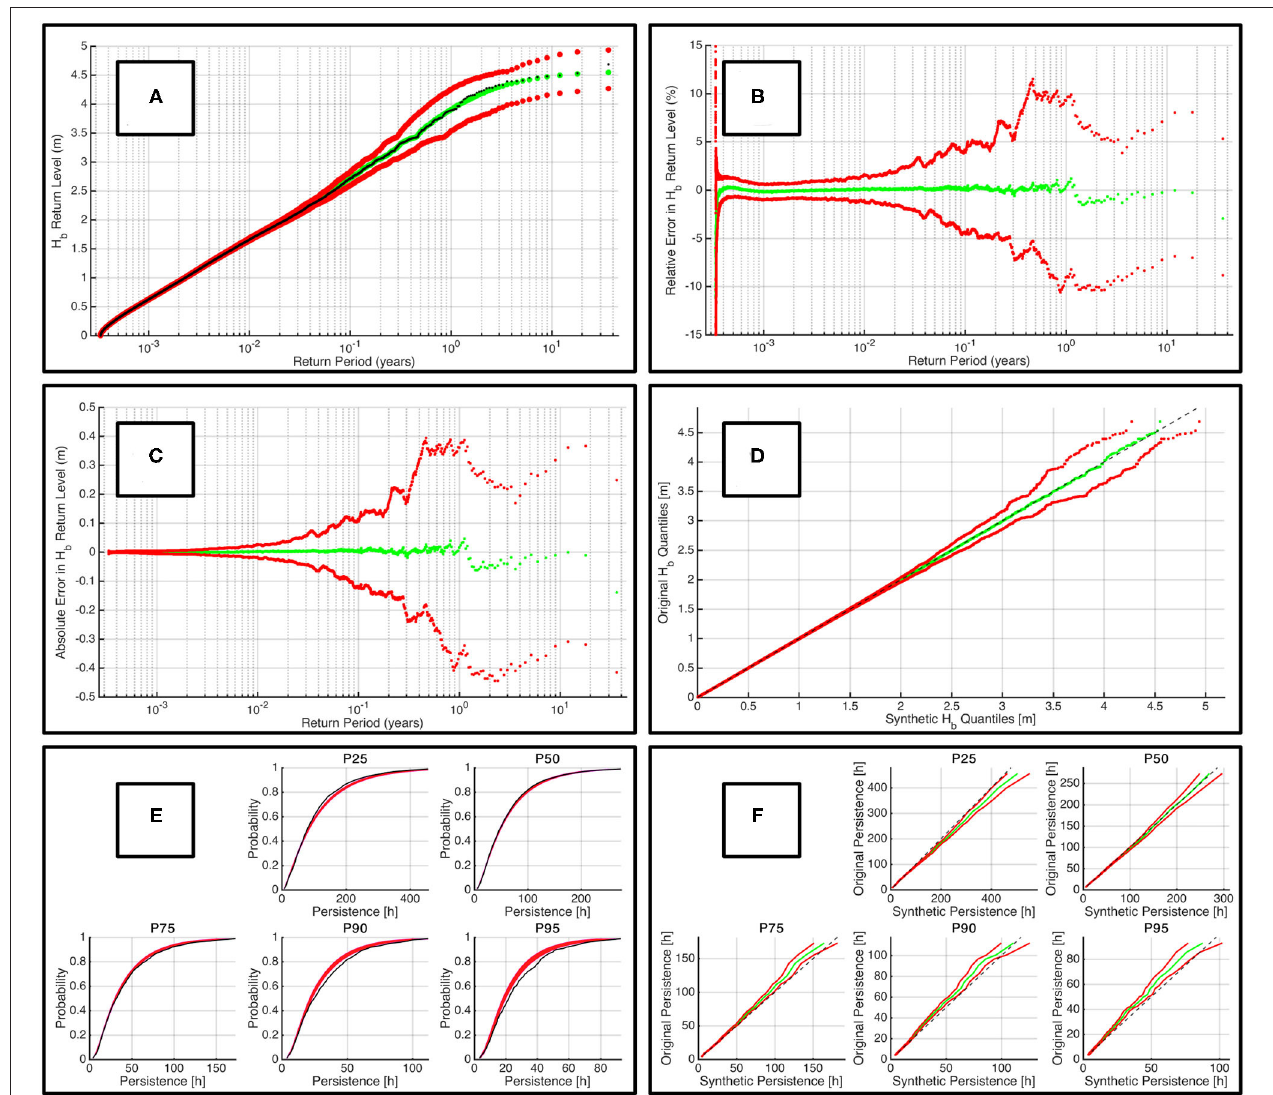
FIGURE A2 | Comparison between the statistics of the original and 1000 synthetic time series of H b for one beach. In all panels, black dots (or lines) indicate the values computed using the original time series; while the lower red dots, central green dots, and upper red dots (or lines) indicate the 5, 50, and 95th percentiles of the values computed from the synthetic time series. (A) Shows the return plots. (B) Shows the error of the synthetic time series return plots with respect to the original time series return plot, while (C) depicts the same but in terms of relative error. (D) Shows the QQ-plots between the original and the synthetic time series. (E) Shows the cumulative density functions of the persistence over different thresholds (defined as the original time series percentiles, marked above each subpanel), both for the original time series (black dots) and the range between the 5 and 95th percentiles of the synthetic time series (red shaded areas). (F) Shows the QQ-plots of the persistence over different thresholds (defined as the original time series percentiles) between the original and the synthetic time series.